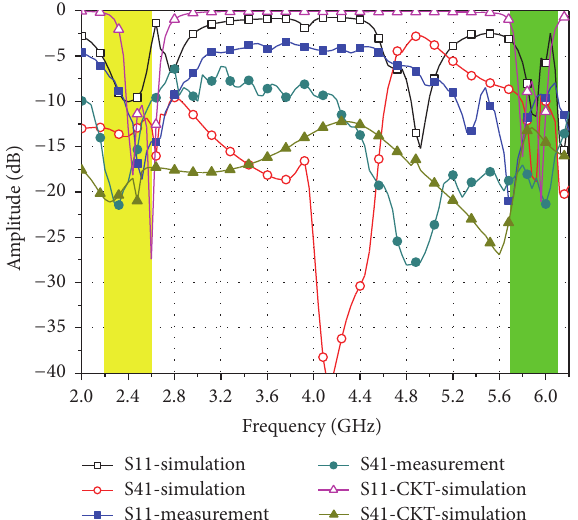
Figure 9: Phase response of the coupler prototype.